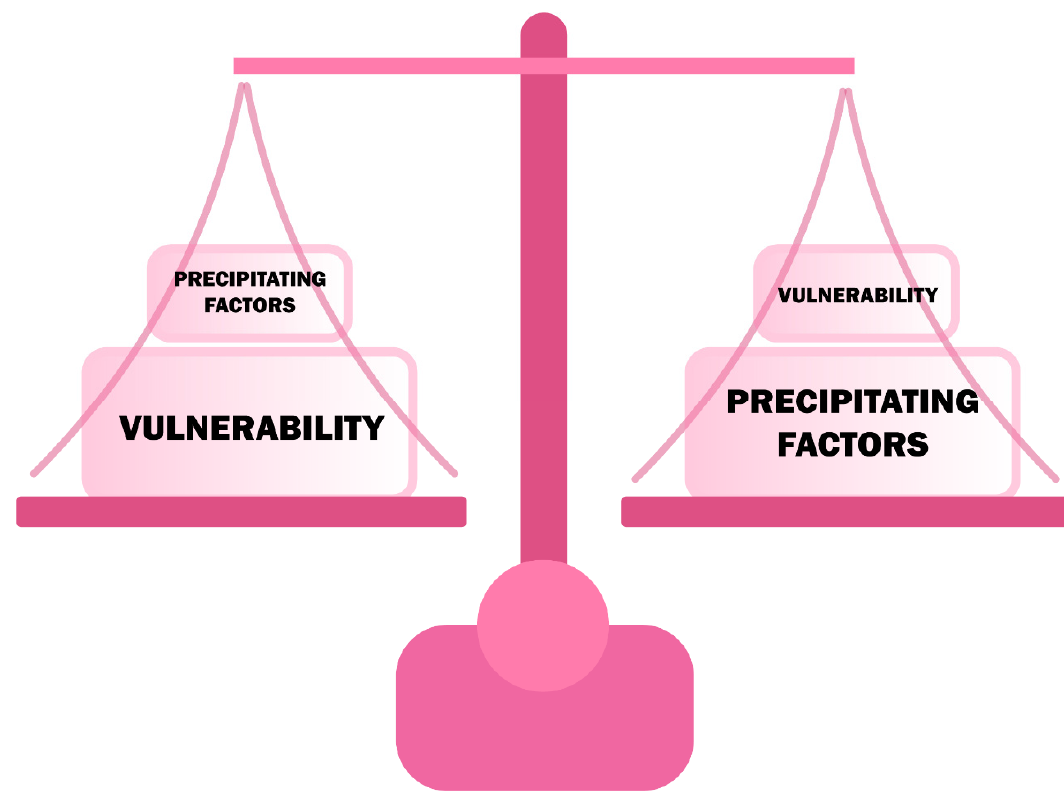
Figure 2. The relationship of vulnerability and precipitating factors in developing delirium.